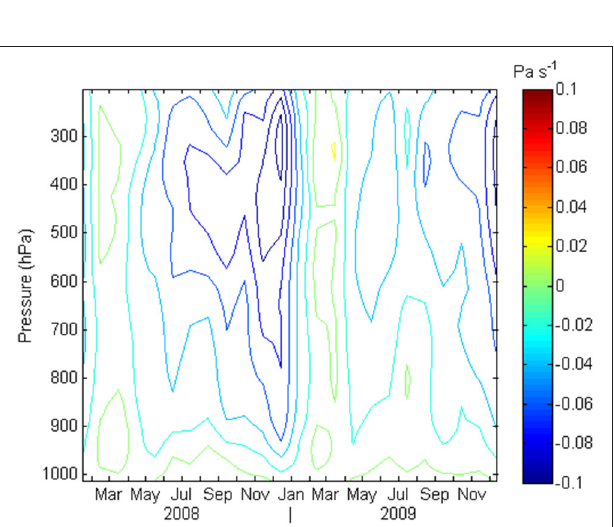
FIGURE 11 | Hovmöller diagram of monthly omega or vertical component of velocity in pressure coordinates (dp/dt), from 2008 to 2009, fixed at 5 ◦ N and averaged between 75 ◦ and 80 ◦ W. Omega is positive down (Pa s − 1